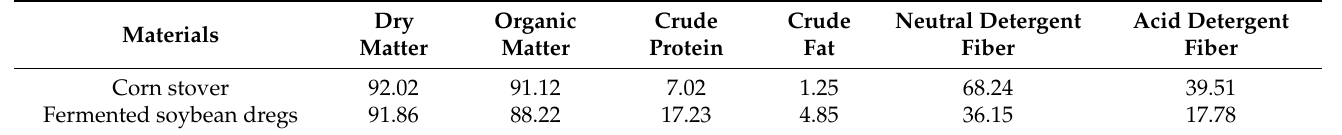
Table 1. Nutrient components of corn stover and fermented soybean dregs (air dried) a . Materials Corn